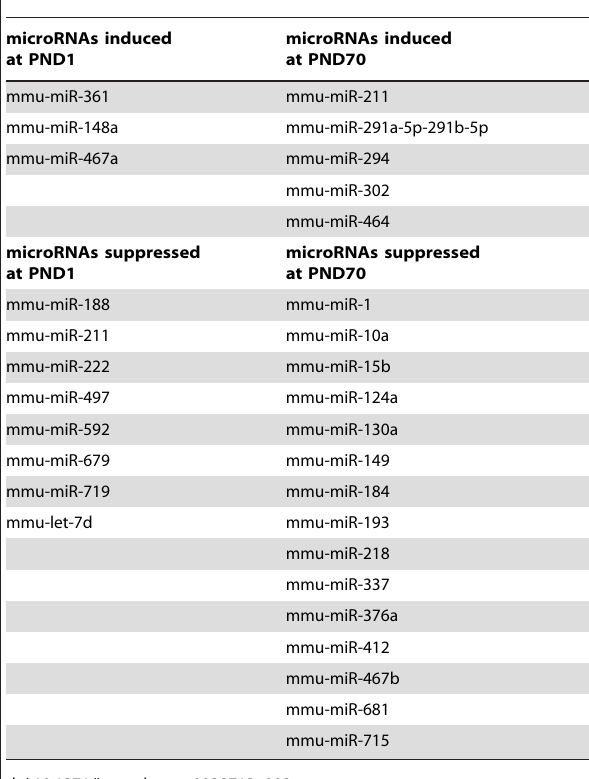
Table 2. microRNAs differentially expressed at PND1 and